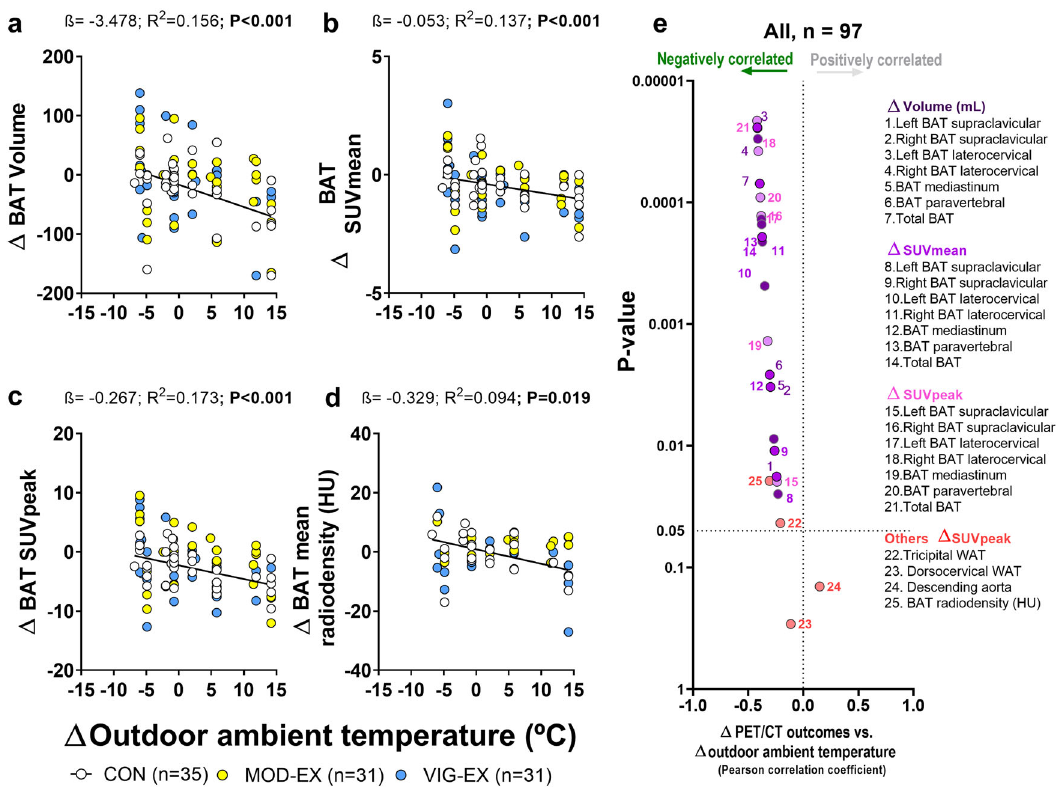
Fig.3|Associationsbetweenthe Δ outdoorambienttemperatureand Δ (post- intervention minus baseline value) brown adipose tissue (BAT)-related out- comes. a Total BAT volume. b Total BAT standardized uptake value (SUV) mean. c TotalBAT SUVpeak. d TotalBAT meanradiodensity (CON n =25; MOD-EX n =17; VIG-EX n =16). e Regional BAT volume, SUVmean, and SUVpeak. SUV values are